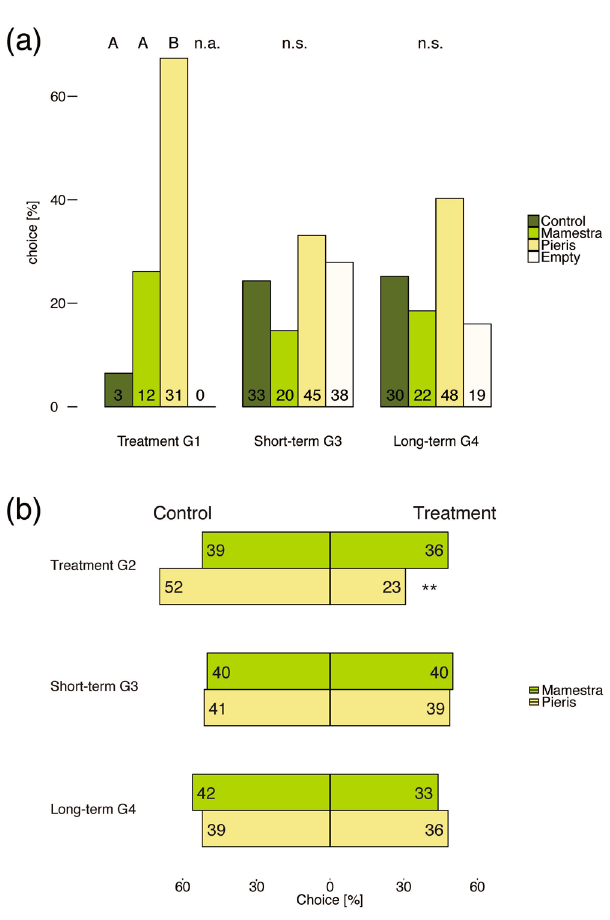
Figure 3. Results of the bioassays with parasitoids and pollinators. (a) Olfactometer tests with the parasitoid wasp C. glomerata . Numbers in bars indicate the absolute amount of wasps in this arm and letters above boxes denote group differences within generation (negative binomial mixed model with post hoc Tukey HSD excluding the empty arm due to complete separation, Z (Control-Pieris) = 3.806, P (Control-Pieris) < 0.001). (b) Results of the dual-choice assays with the pollinator B. terrestris (binomial test, P =